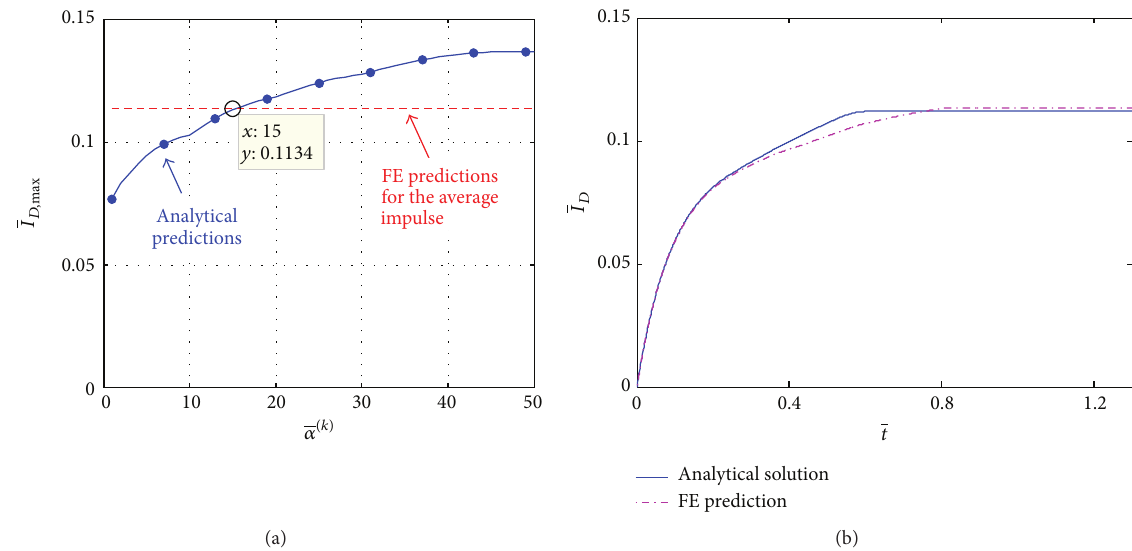
Figure 24: Comparison of analytical solution and FE predictions of (a) the nondimensional maximum impulse and (b) the nondimensional impulse time